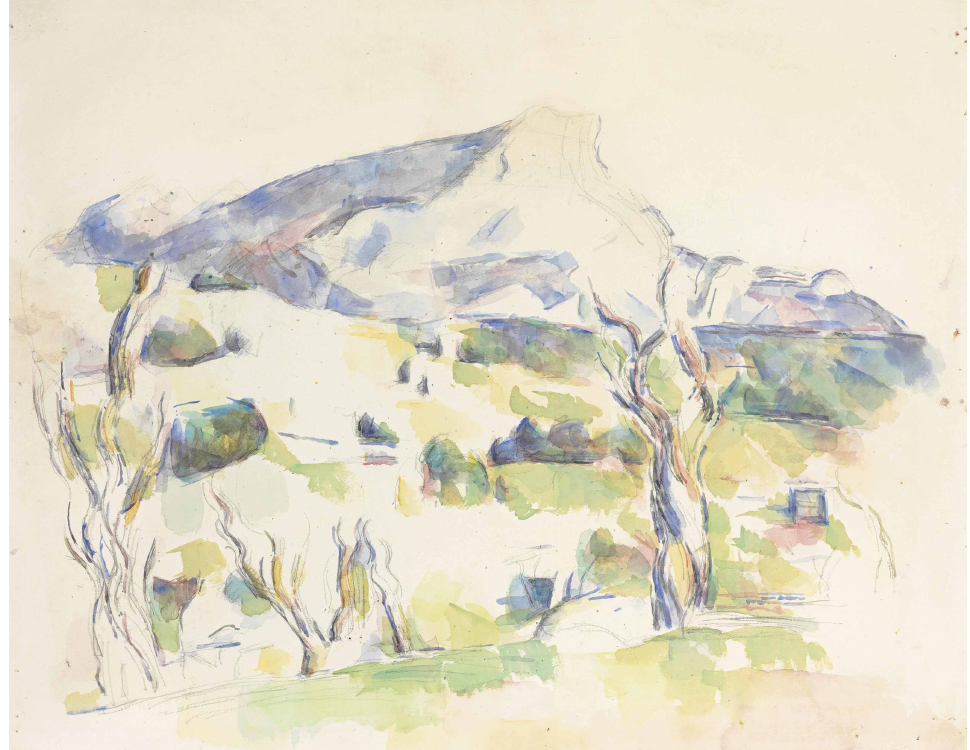
Figure 3: Paul Cézanne, Mont Sainte-Victoire ,